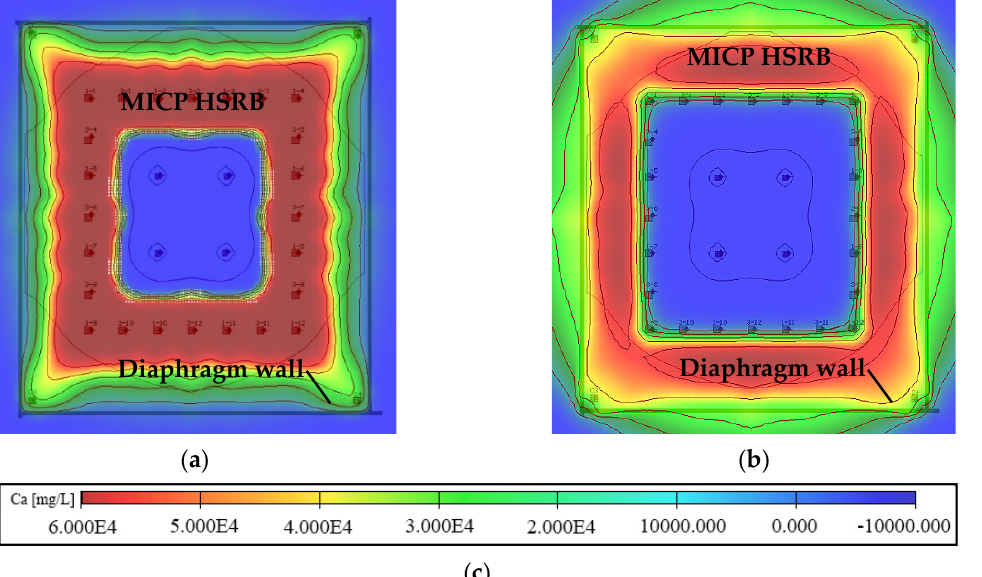
Figure 27. Horizontal migration diagram of cementation fluid: ( a ) Horizontal migration after 1 day of perfusion; ( b ) horizontal migration driven by seepage field for 1 day after grouting is stopped; (c) Legend.